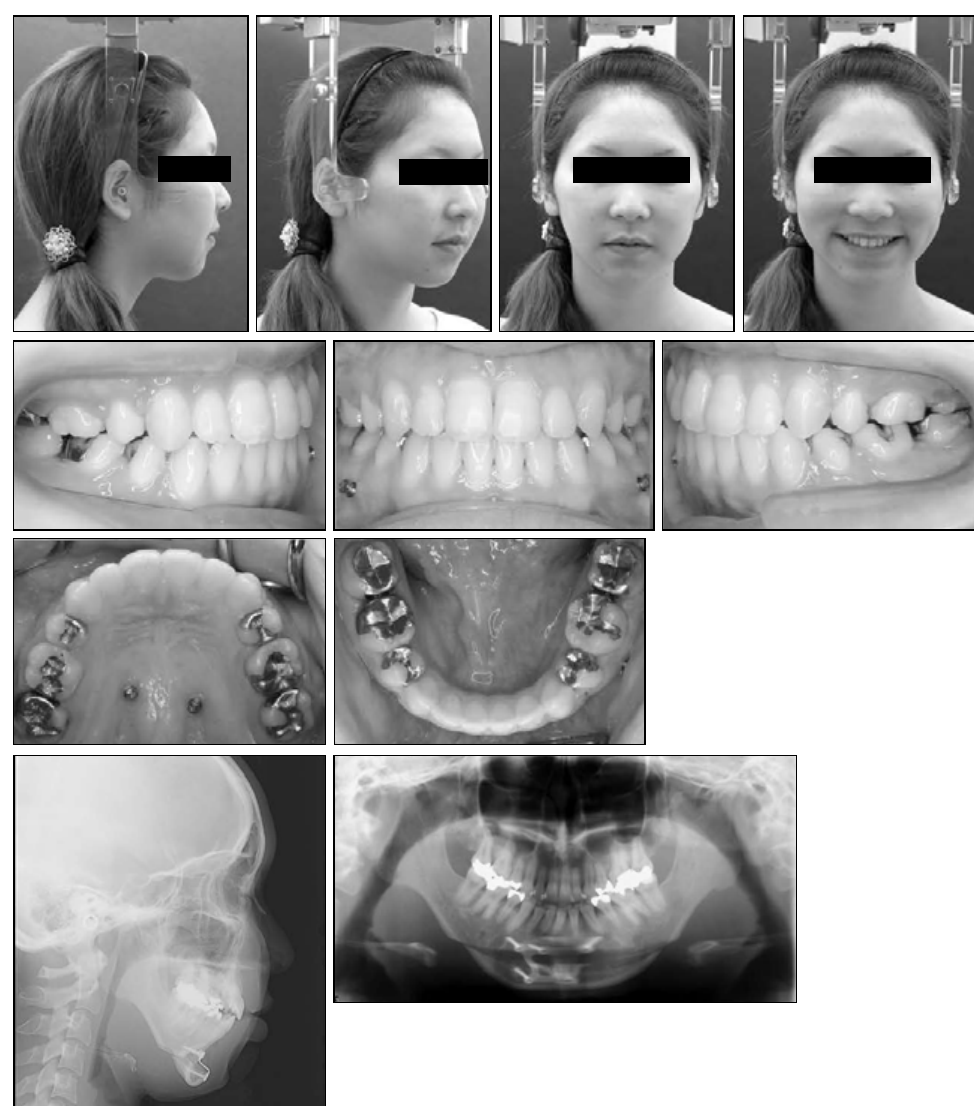
Figure 4. Post-active treatment photographs and